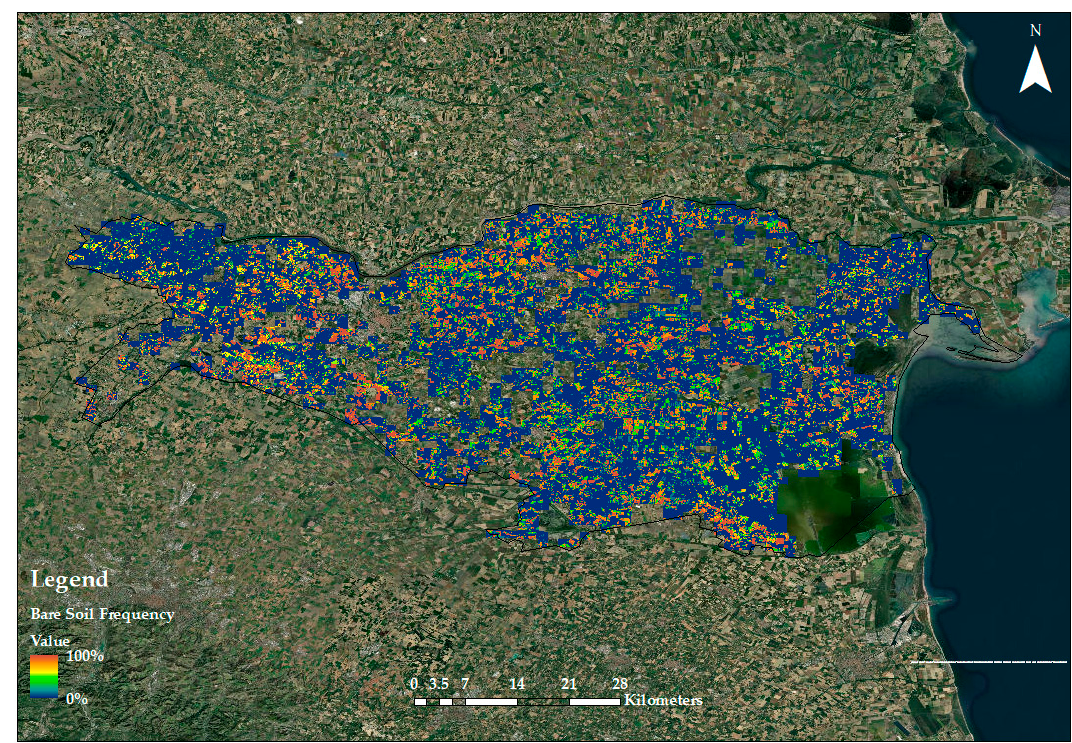
of the Italian National Institute of Statistics. The results indicated no change between the cultivated area all over the years. Figure 7. Bare soil frequency map of the Ferrara region for the month of September, average over the four years of data.